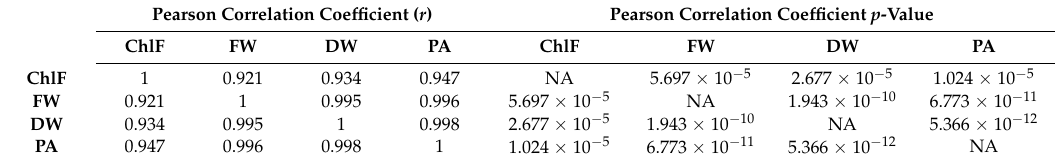
Table 1. Pearson correlation coefficients and p -values for correlations between measured quantities. Pearson Correlation Coefficient ( r ) Pearson Correlation Coefficient p